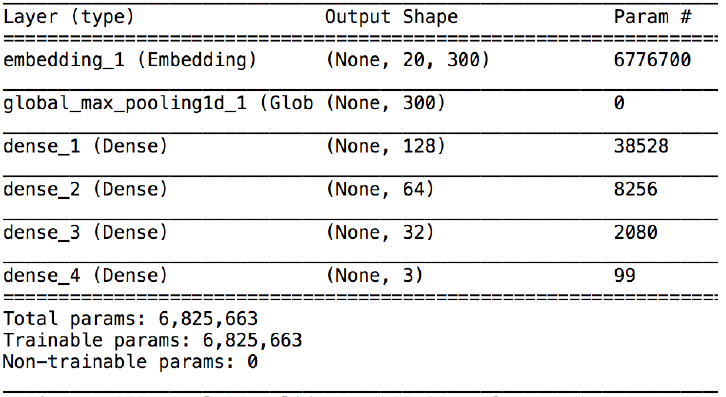
Figure 7. Baseline model summary.